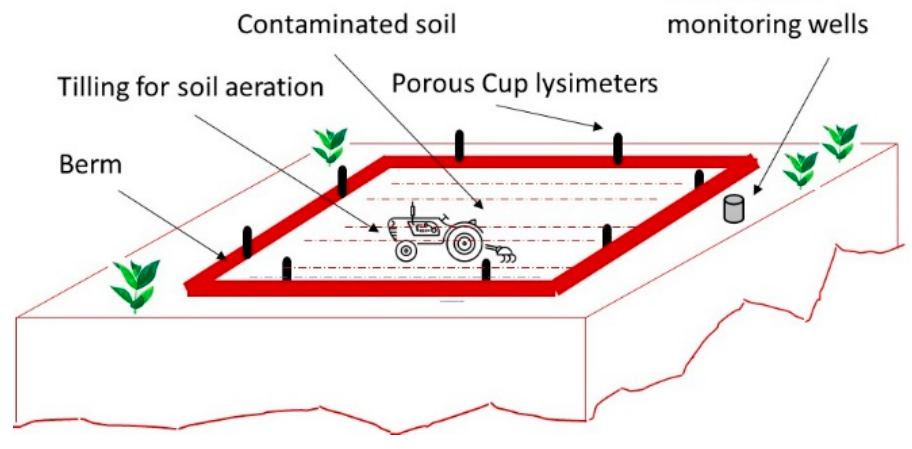
Figure 9. Typical landfarming system (adapted from [93]).